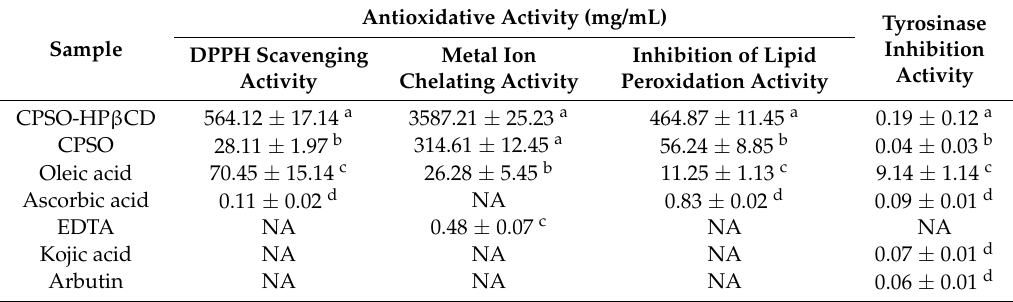
Table 2. IC 50 (mg/mL) values of biological activities, including antioxidative and tyrosinase inhibition activities of CPSO-HP β CD inclusion complex, compared to CPSO and standard